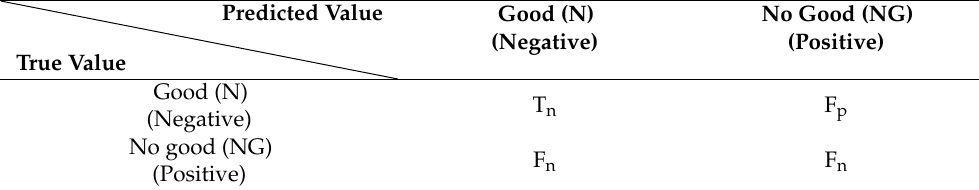
Table 1. Confusion Matrix.